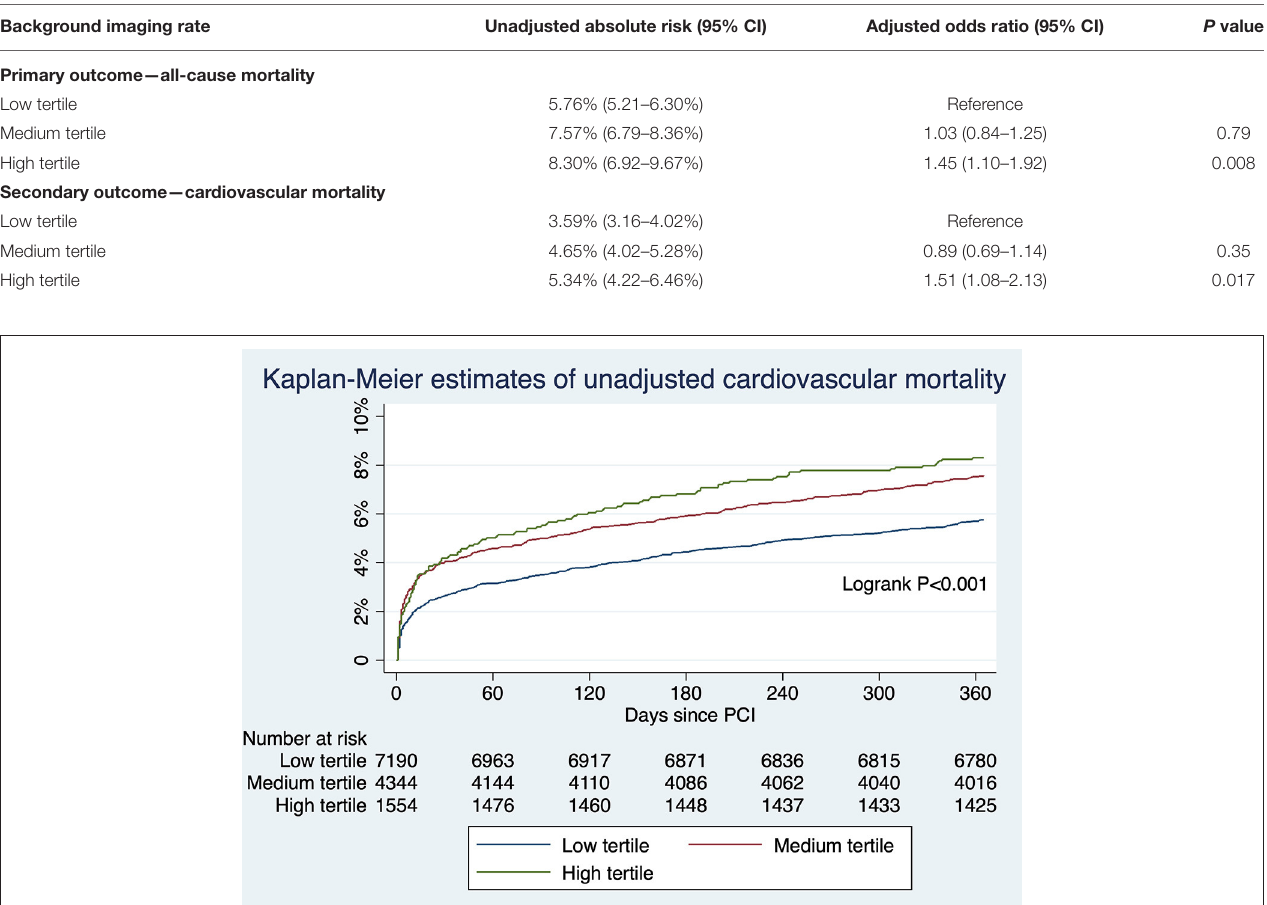
TABLE 5 | Association between background imaging rate and outcomes restricted to the patient undergoing angiography-guided PCI.